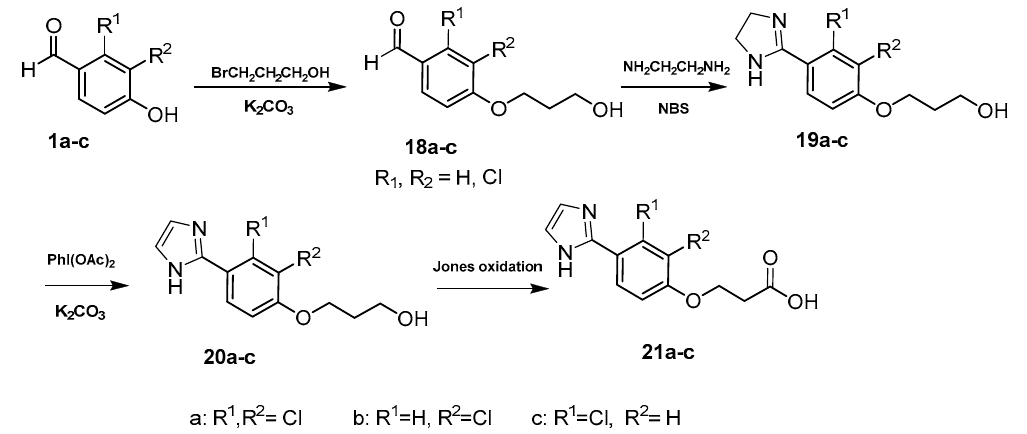
Scheme 5 . Synthesis of 2-[Di/monochloro-4-(1 H -imidazol-2-yl)phenoxy]propionic acids. Scheme 5. Synthesis of 2-[Di/monochloro-4-(1 H -imidazol-2-yl)phenoxy]propionic acids.